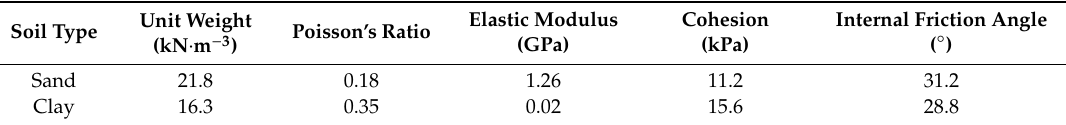
Table 2. Physical and mechanics